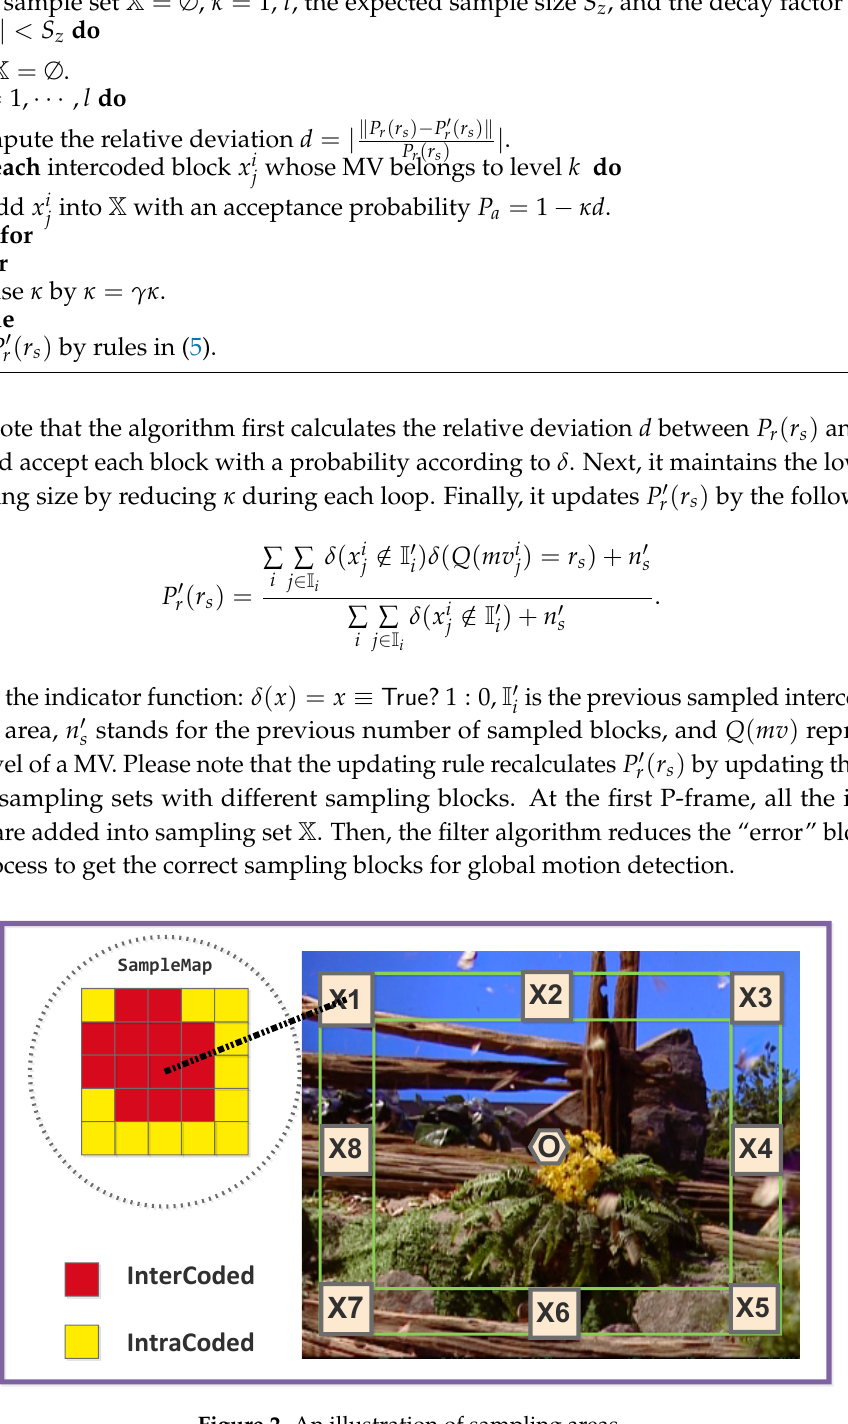
Figure 2. An illustration of sampling